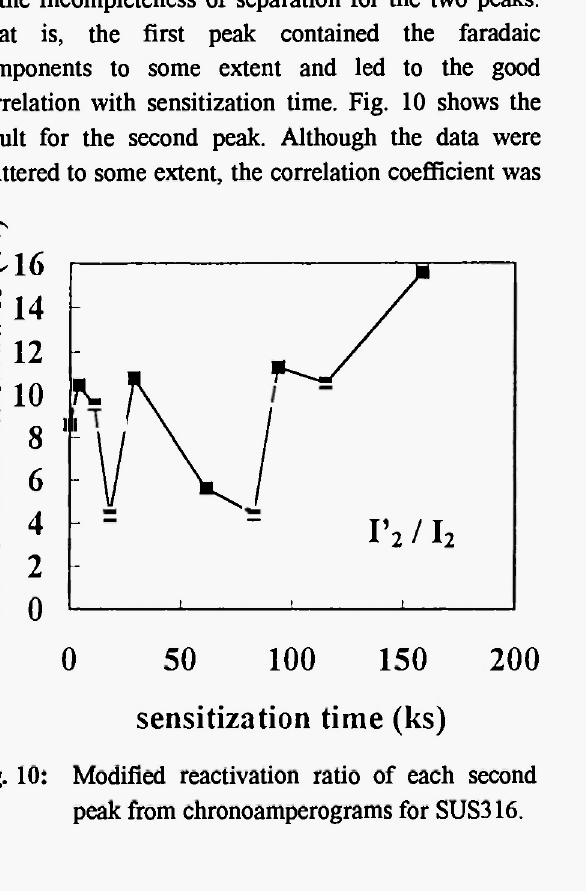
Fig. 10: Modified reactivation ratio of each second peak from chronoamperograms for